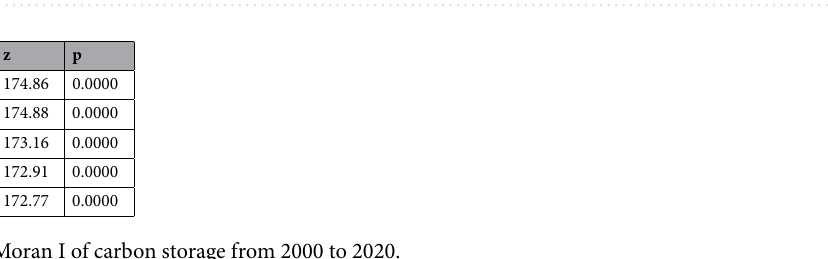
Figure 3. Spatio-temporal distribution of carbon storage from 2000 to 2020. Map generated with ArcGIS 10.2 (ESRI).